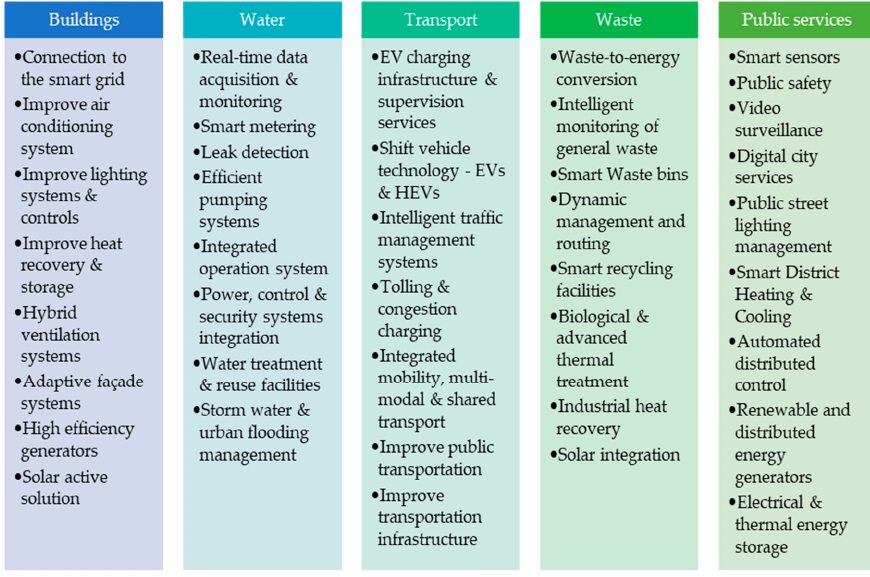
Figure 1. A summary of key smart energy management (SEM) solutions in different sectors.